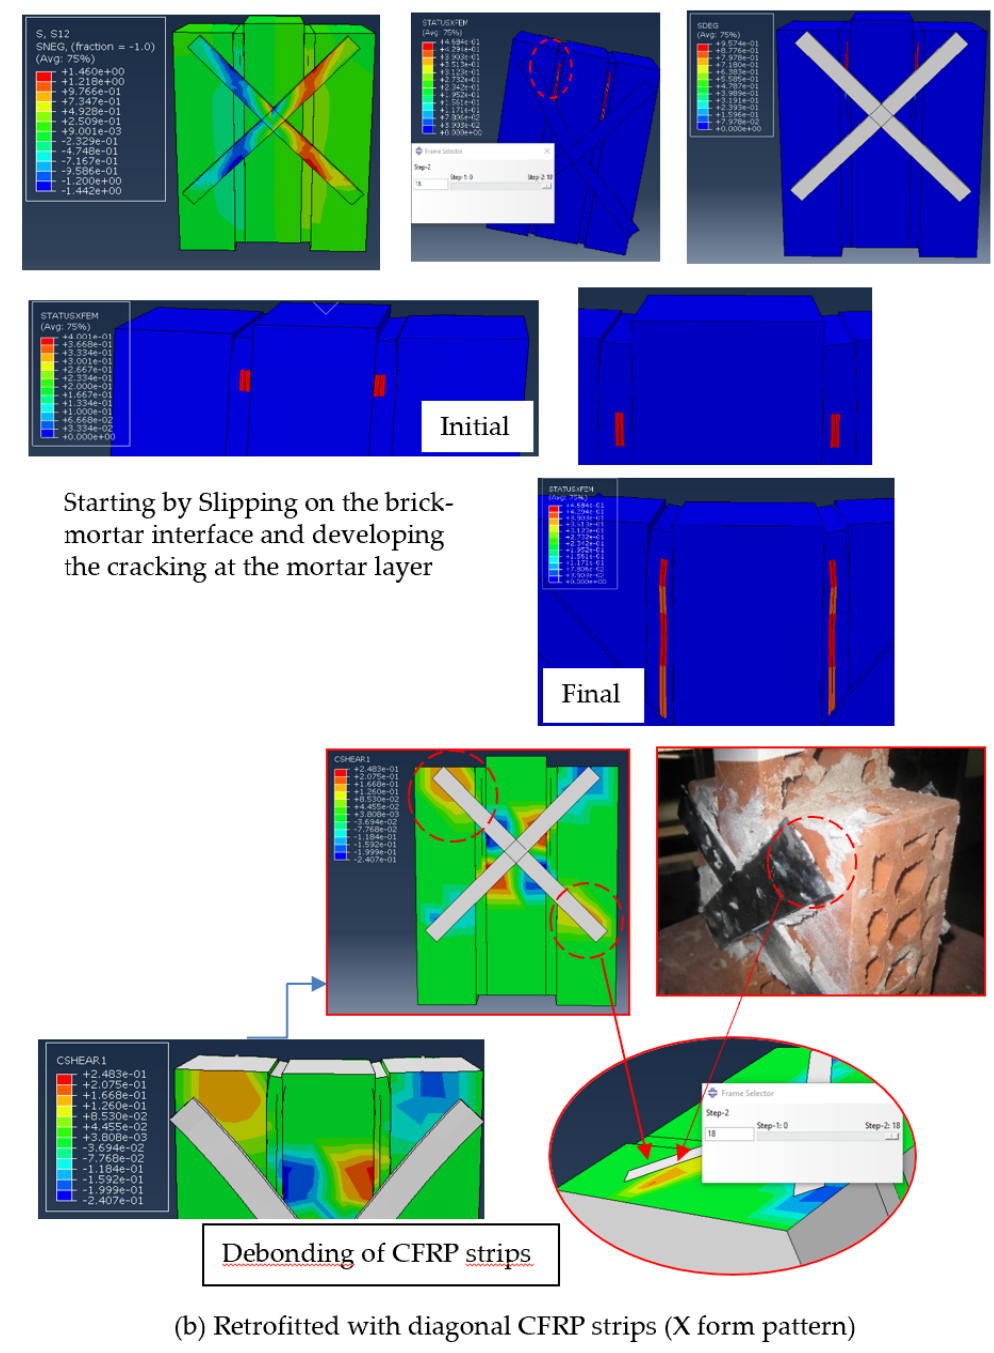
Figure 11. Shear stress contour plots; failure mechanisms for reinforced masonry shear triplets with different configuration of FRP strips: ( a ) retrofitted with CFRP strips parallel to mortar; ( b ) retrofitted with diagonal CFRP strips (X form pattern).